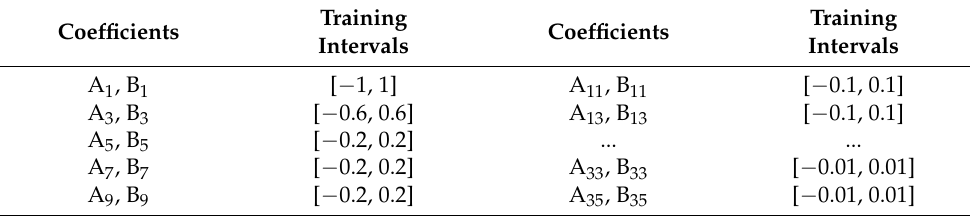
Table 1. Value intervals of the rectangular coefficients used in the generation of training